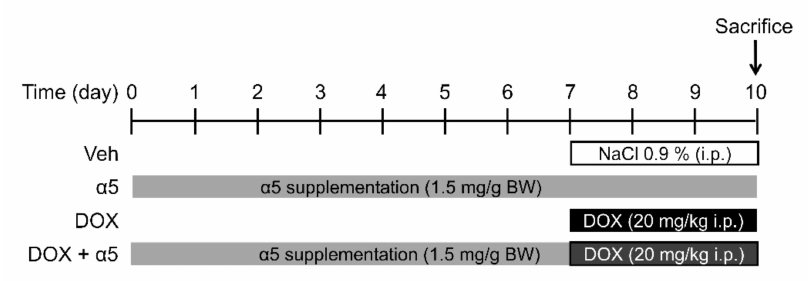
Figure 2. In vivo mouse treatment.